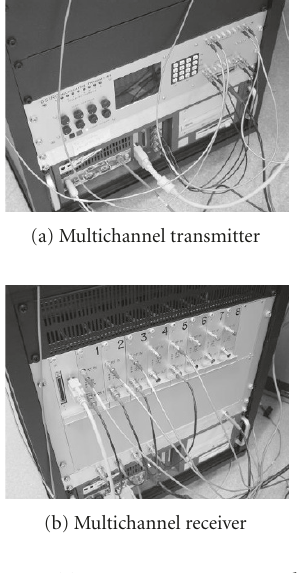
Figure 1: CSIRO ICT Centre MIMO-OFDM